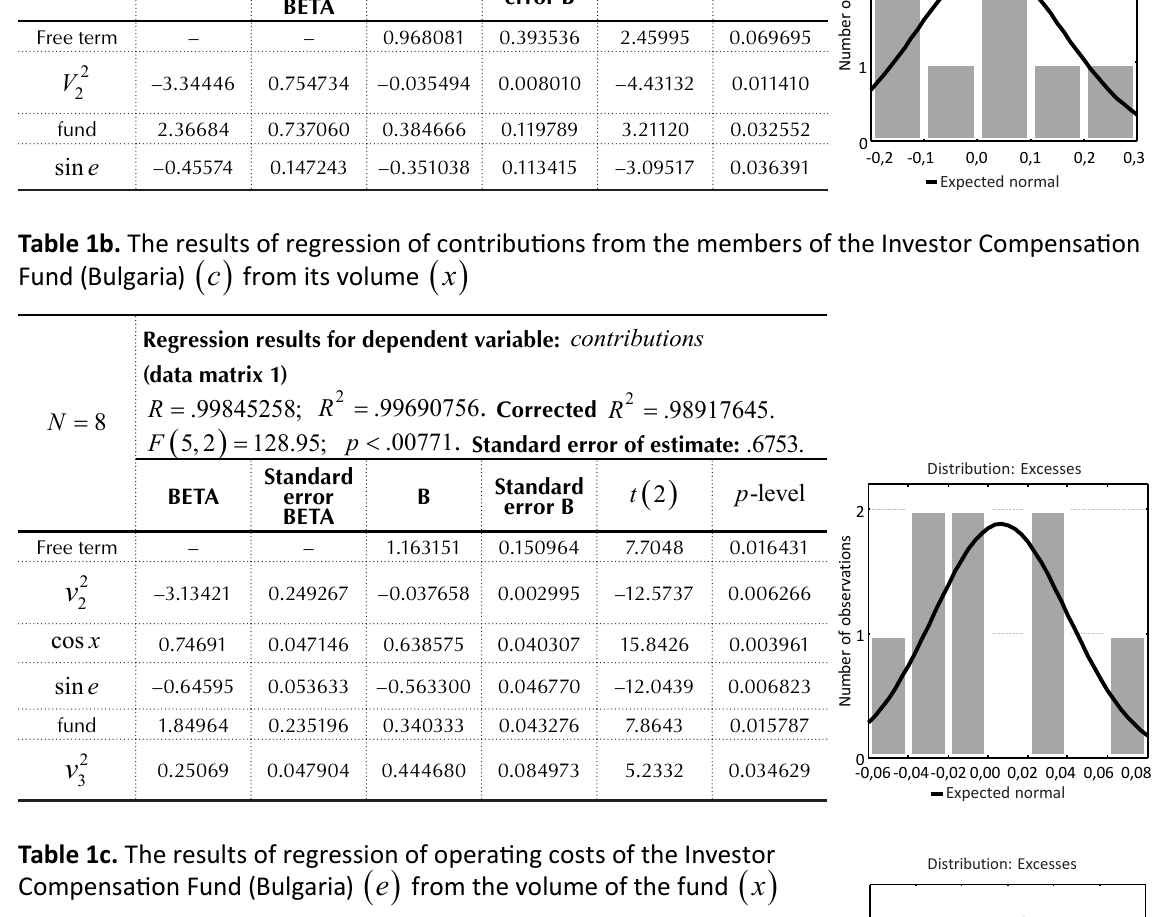
Table 1a. The results of regression of the standard deviation of the size of the Investor Compensation Fund (Bulgaria) ( ) y from its volume ( ) x Regression results for dependent variable: risk (data matrix 1) 8 N =